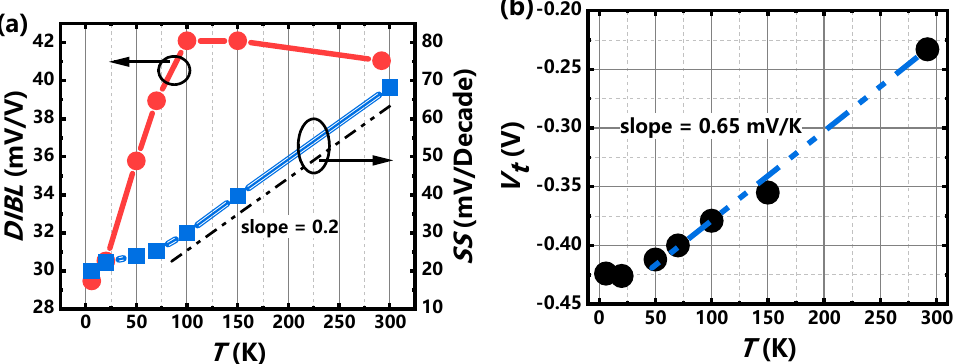
Figure 3. The temperature ( T ) dependence for extracted ( a ) DIBLs and SSs and ( b ) V t s of the GAA Si NW FET.